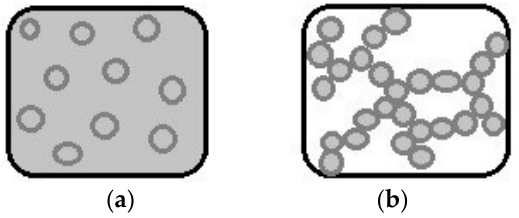
Figure 1. Theoretical representation of the two structures involving gels and emulsions in combination: ( a ) Emulsion-filled gel and ( b ) Emulsion gel. ( a ) Emulsion-filled gel and ( b ) Emulsion